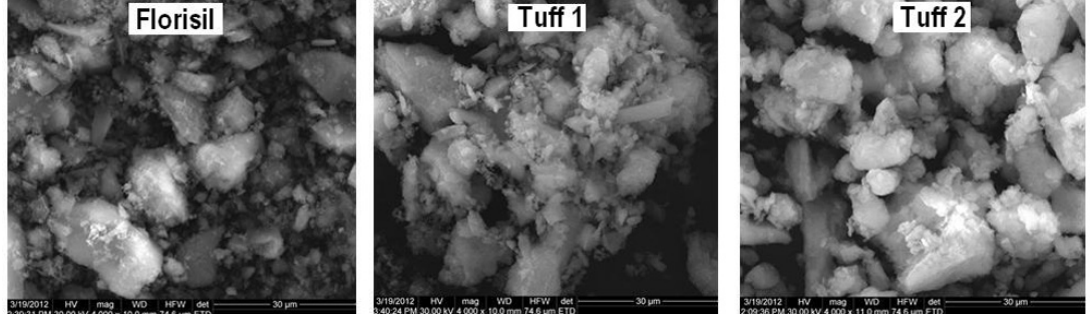
Figure 4. SEM microphotographs of the studied catalysts.